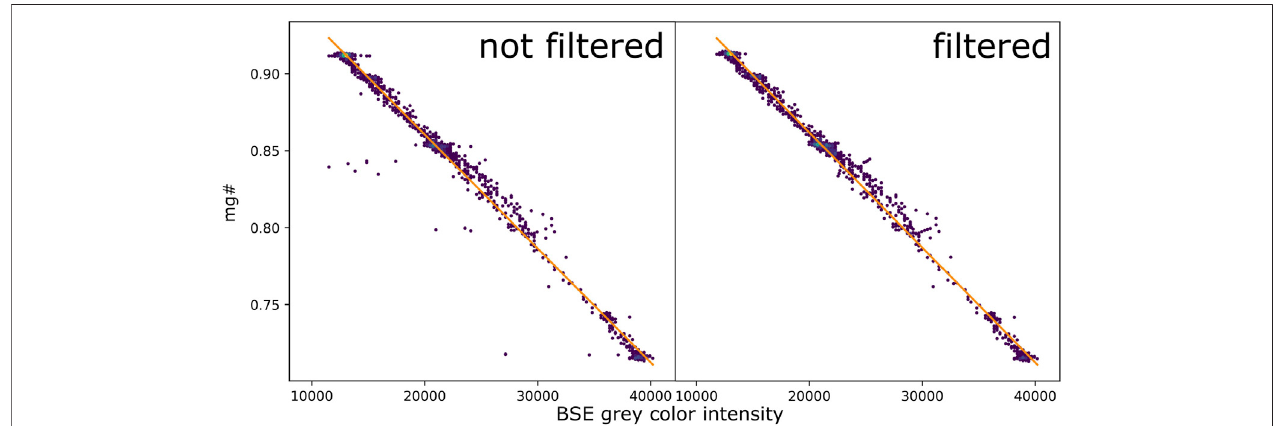
FIGURE 7 | Regression task – simple parameterization of the microprobe mg# against SEM BSE grey level intensity performed on the Calibration-Data using selectedrepresentativenormally andreversely zonedolivines.Thecalibration linesareshown inorange. Onthe fi lteredleftimageoutlierpointsarevisibletotheleftofthe calibration line and on the right image the outliers are removed.